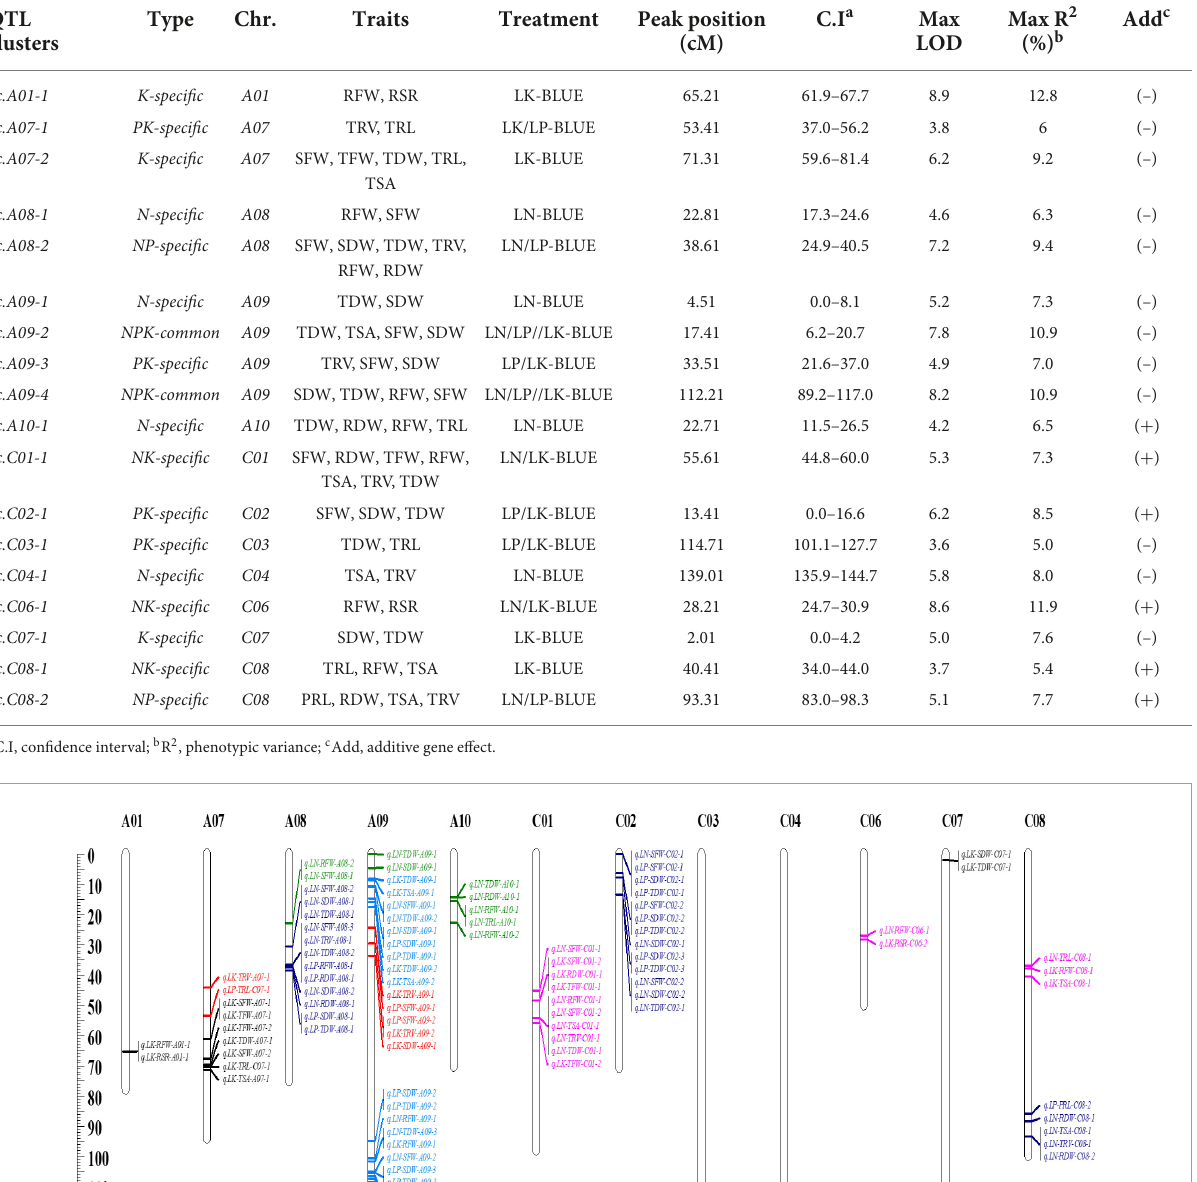
TABLE 2 Summary of quantitative trait loci (QTL) clusters detected under NPK-stress in the recombinant inbred line (RIL) population.